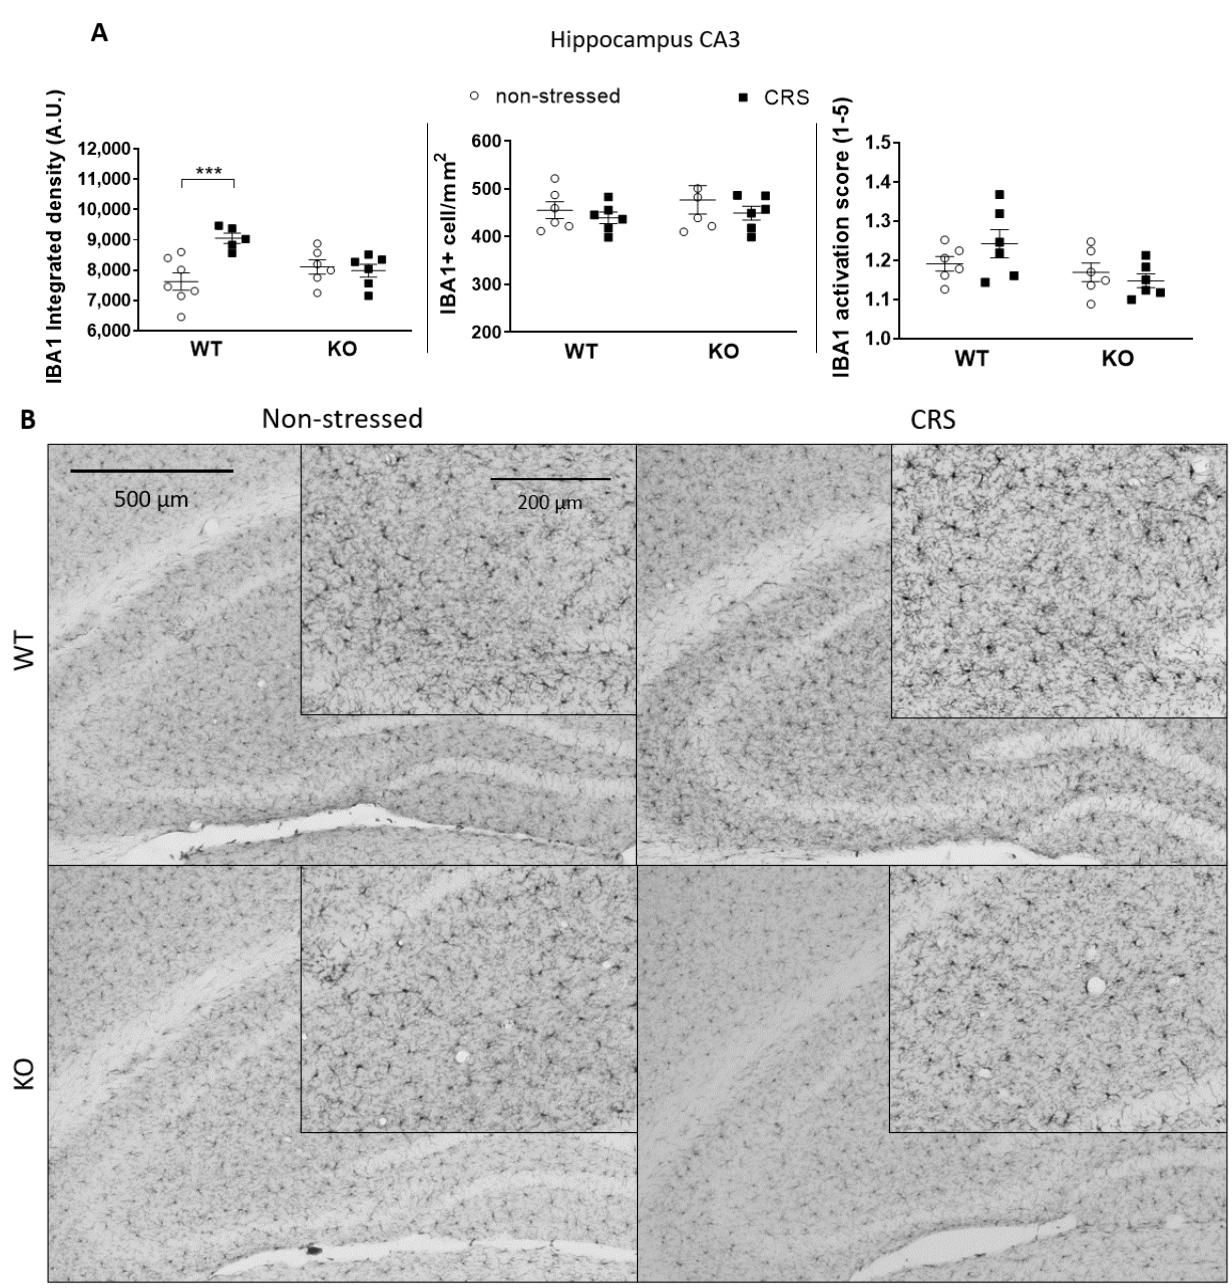
Figure 8. Diagrams show the Ionized calcium-binding adaptor molecule 1 (IBA1) integrated density, the number of IBA1+ cells and the IBA1 activation score of microglia examined in the hippocampus CA3 region (CA3—( A )). Representative images show the IBA1+ microglia cells in CA3 ( B ). Chronic restraint stress (CRS), Wild-type (WT), Interleukine-1 knock-out (KO). Data are presented as the means ± SEM of n = 5–7 animals with individual plots; two-way analysis of variance (ANOVA), followed by Tukey’s tests; *** p < 0.001 vs. respective group.